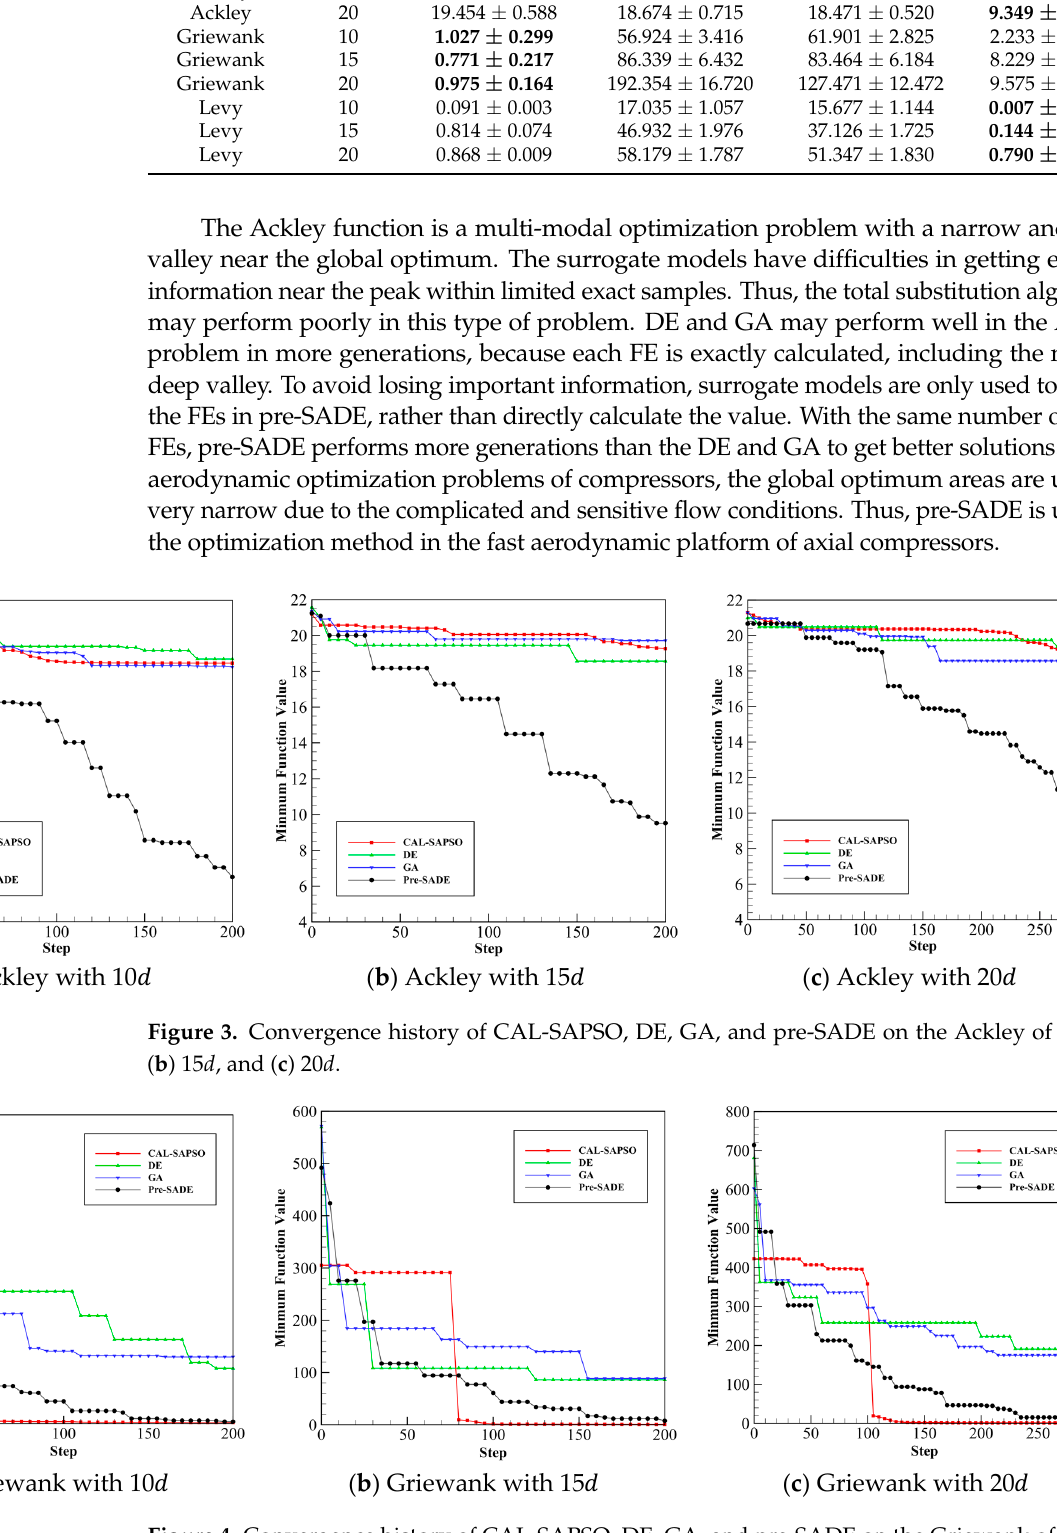
Figure 4. Convergence history of CAL-SAPSO, DE, GA, and pre-SADE on the Griewank of ( a ) 10 𝑑 , ( b ) 15 𝑑 , and ( c ) 20 𝑑 .